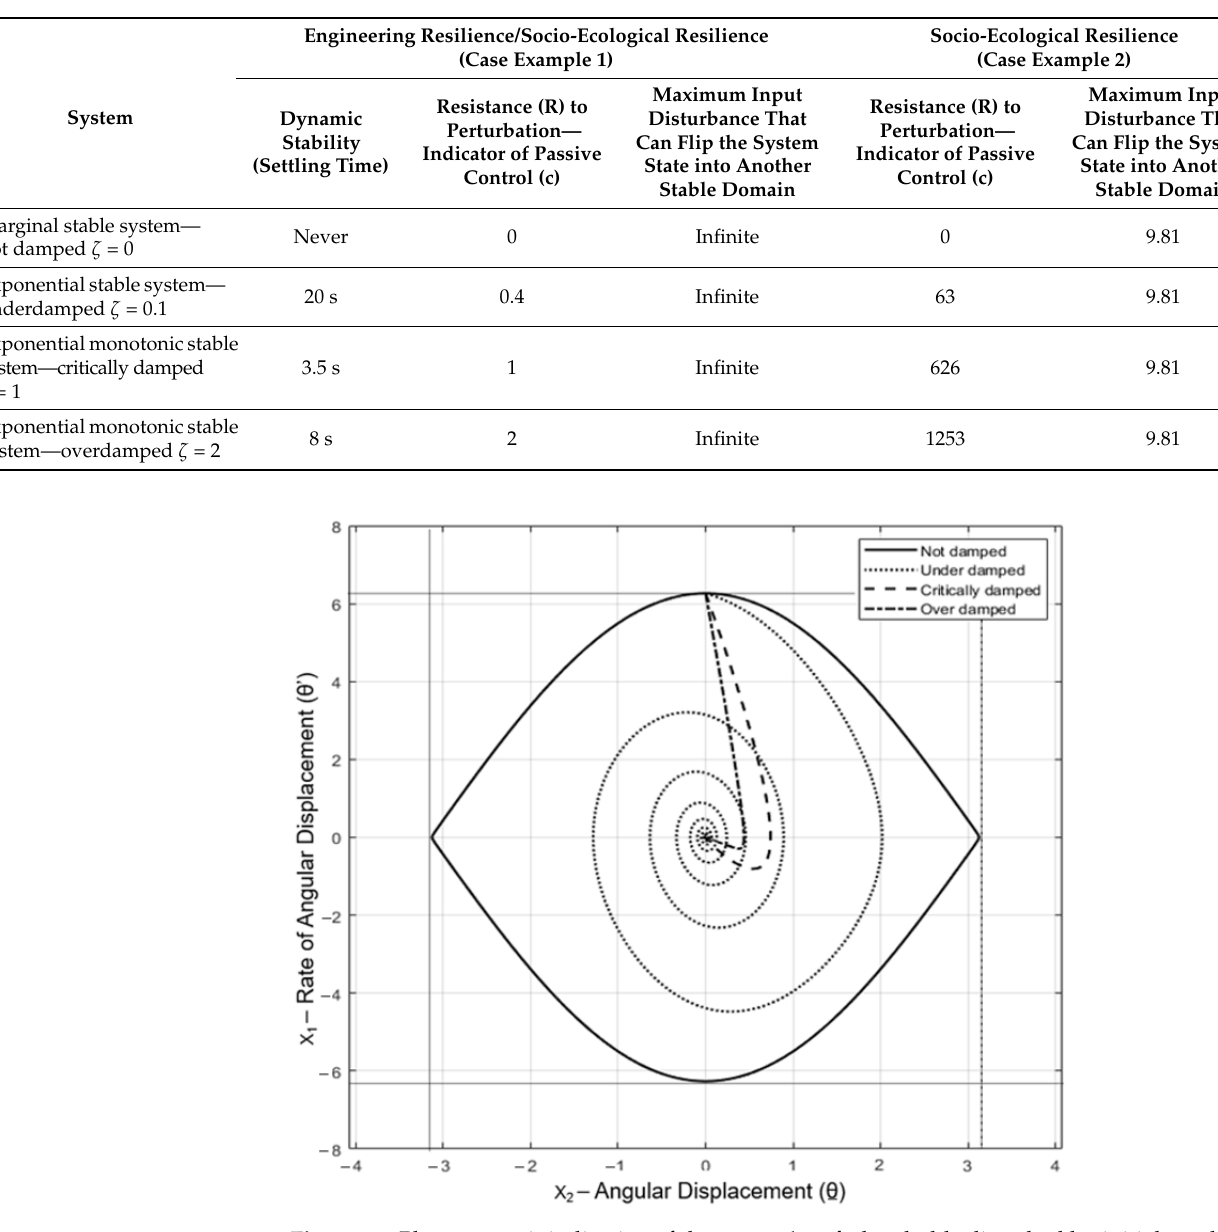
Table 7. Dynamic stability as a measure of engineering resilience for impulse input disturbance ( δ (t)) (Case examples 1 and 2).